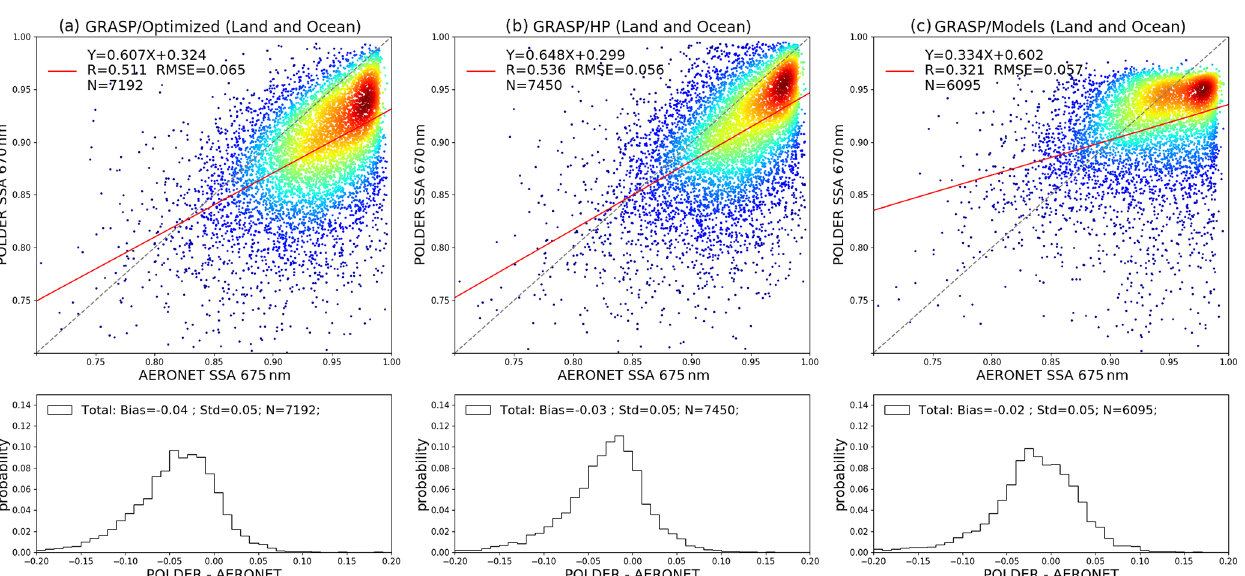
Figure 6. Evaluation of all archive PARASOL/GRASP SSA values at 670nm with AERONET SSA at 675nm: (a) GRASP/Optimized, (b) GRASP/HP, (c) GRASP/Models. The gray dashed line and the red solid line are the 1 : 1 reference line and the linear regression